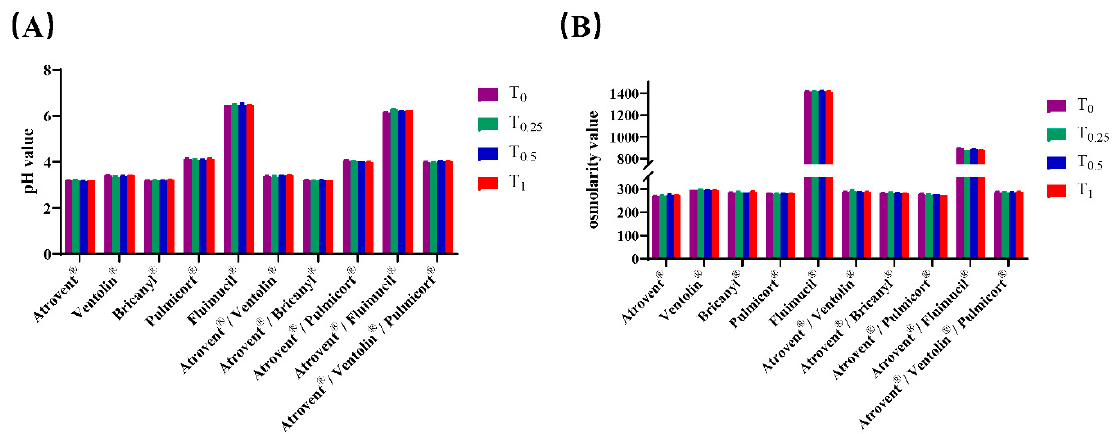
Figure 1. The pH value ( A ) and osmolarity value ( B ) of test samples over time. Experiments were replicated 5 times.